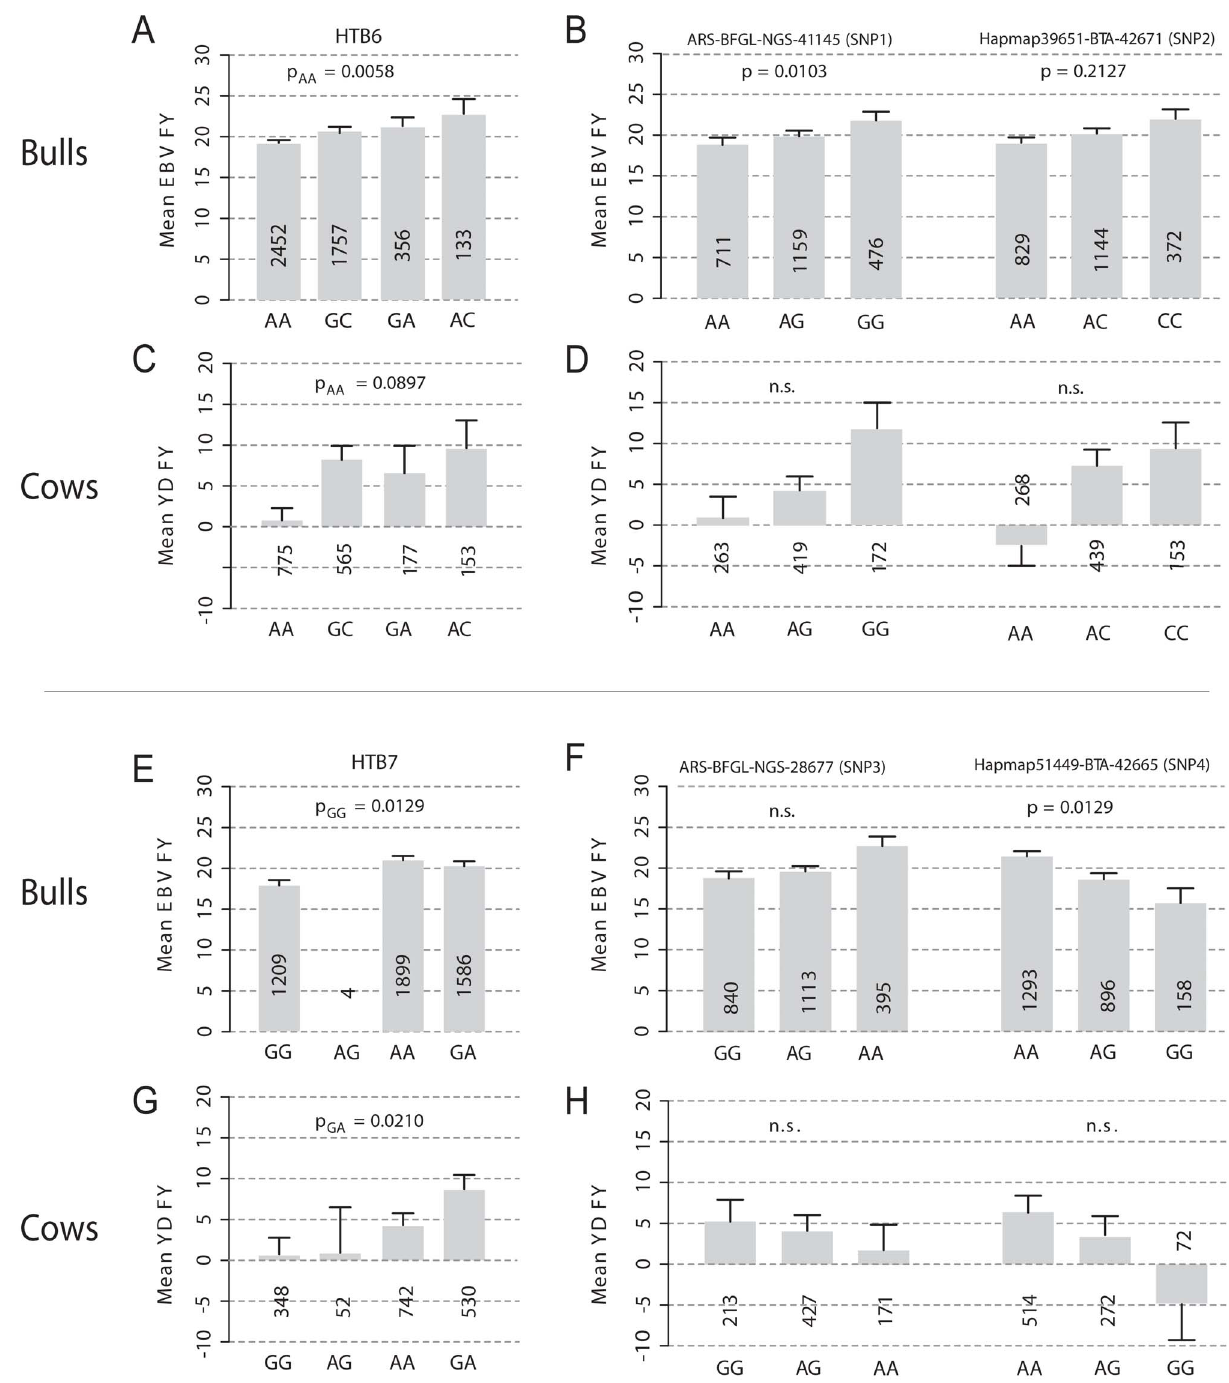
Figure 2. Effect plots for significant haplotype blocks (A, C, E, G) and SNPs building these blocks (B, D, F, H) in the bull (A, B, E, F) and cow population (C, D, G, H). Haplotype block HTB6 consists of the SNPs ARS-BFGL-NGS-41145 (SNP1) and Hapmap39651-BTA-42671 (SNP2); HTB7 of ARS-BFGL-NGS-28677 (SNP3) and Hapmap51149-BTA-42665 (SNP4). Shown are mean and standard error for estimated breeding values (EBVs) and yield deviations (YDs) for milk fat yield (FY) over lactations 1 to 3 in bulls and cows, respectively. EBVs of bulls represent the milk production of daughters, YD of cows refer to own milk production data. Numbers represent counts of observed genotypes and haplotypes, respectively. Haplotypes are ordered according to their frequency in bulls, beginning with the most frequent haplotype. The frequency of haplotype AG in HTB7 was below 1% in the bull population and was not considered in the association study. P-values are given for regression model 4 (Table 1) considering population stratification and DGAT1 effects. For significantly associated SNPs and haplotypes, Bonferroni corrected p-values of the regression model are given for the bull population; for the cow population p-values of the Tukey Kramer test are given for SNPs and p-values of the mixed model are given for the haplotypes (Tables 2 and 3). P AA and P AG are p-values for the haplotypes AA and AG in HTB6 and HTB7, respectively, indicating that these haplotypes differ significantly from the group of other haplotypes in the corresponding haplotype block (Table 3).